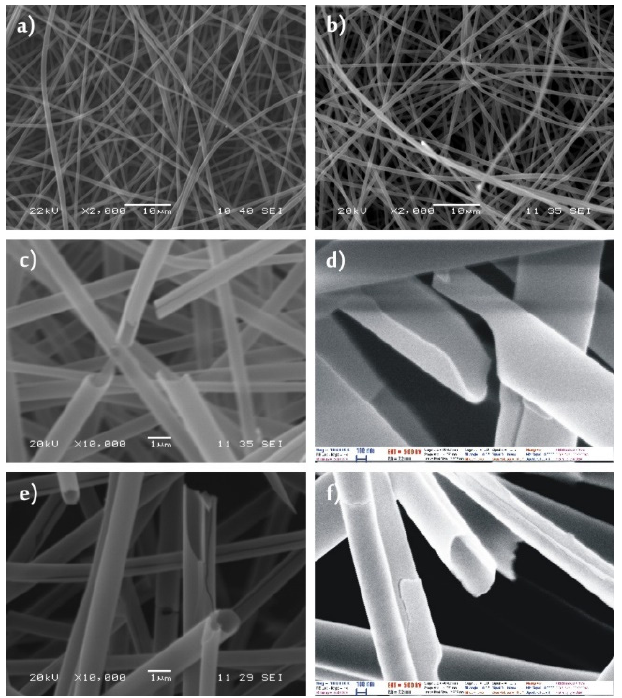
Figure 2. SEM images of ( a ) PVP nanofibers; ( b ) PVP/TiO 2 composite nanofibers, ( c , d ) TiO 2 nano- tubes obtained from the PVP/TiO 2 composite by dissolution, ( e , f ) TiO 2 nanotubes obtained from the PVP/TiO 2 composite by annealing.